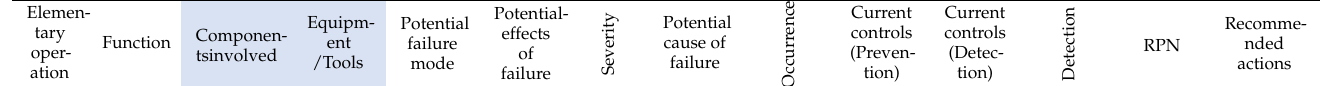
Table 2. Table used to conduct the